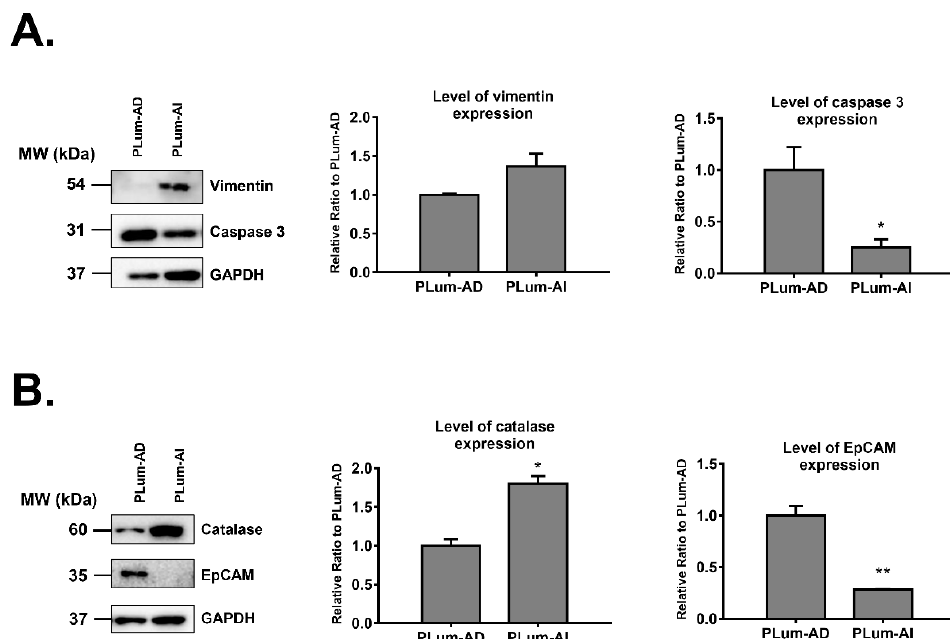
Figure 3. Western blot validation of four proteins identified by mass spectrometry to be di ff erentially expressed in PLum-AI relative to PLum-AD cells ( n = 3). ( A ) Western blot validation of vimentin and caspase 3 proteins. ( B ) Western blot validation of catalase and EpCAM proteins. Bands were detected